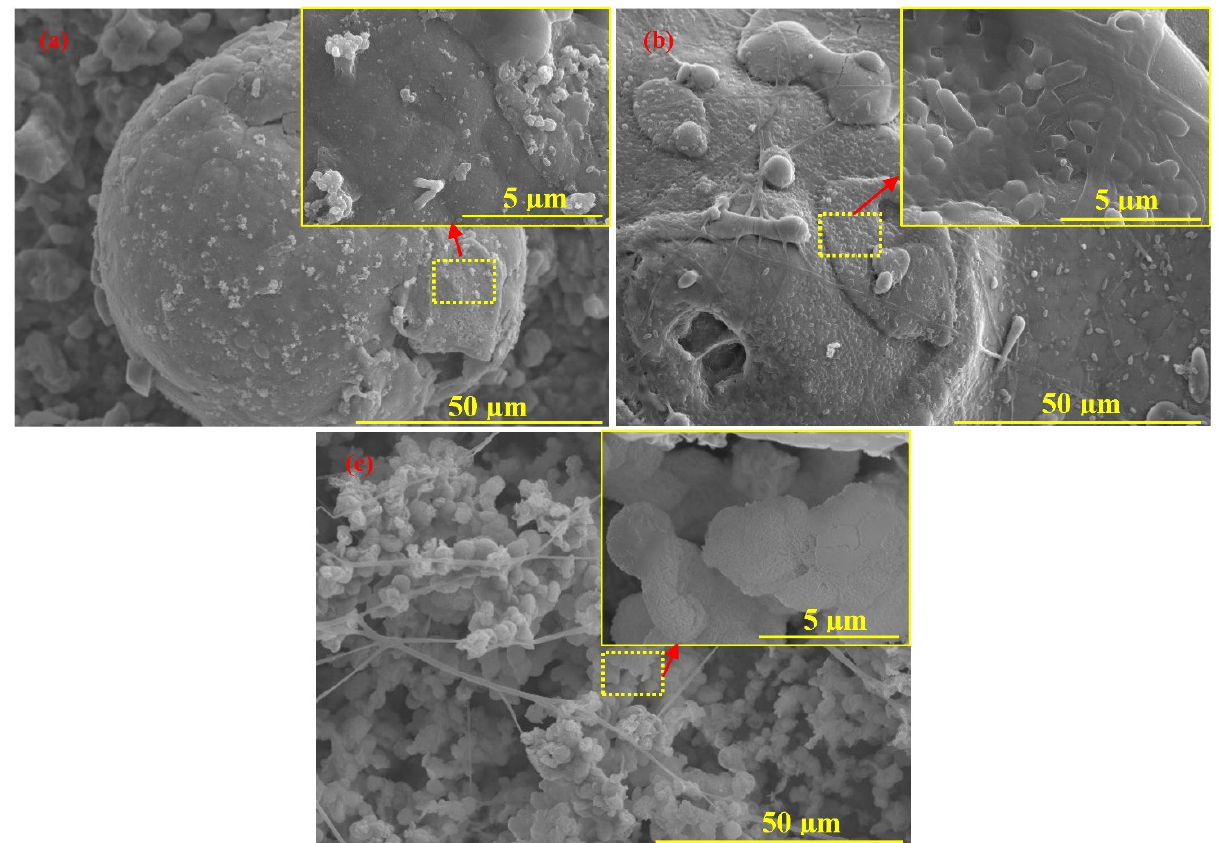
Figure 7. SEM of corrosion products formed on ( a ) Cu, ( b ) Ti, and ( c ) 85Zn-15Al coatings after 28 days of immersion in 5 wt.% NaCl solution. Table 5. EDS analysis of corrosion products formed in 5 wt.% NaCl solution after 28 days of im-